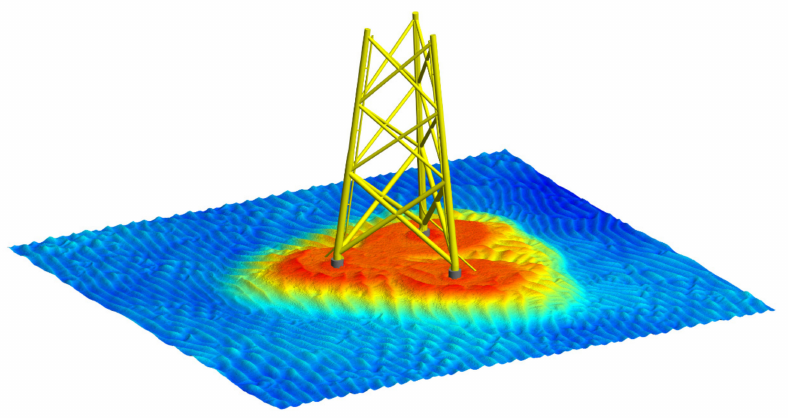
Figure 1. Jacket foundation of East Anglia ONE (laser scanner measurement from physical tests at IHCantabria